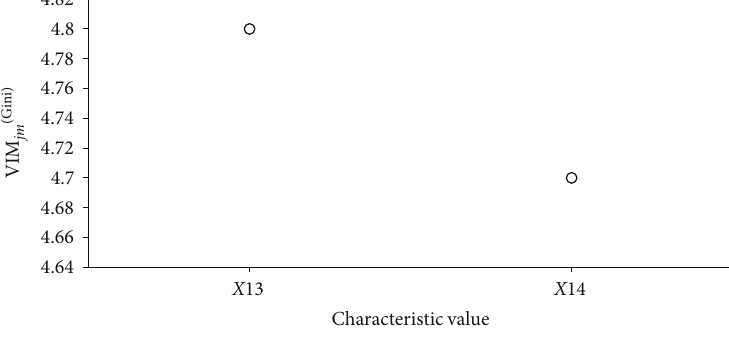
Figure 6: Gini coe ffi cient importance scatter plot of physical characteristics.